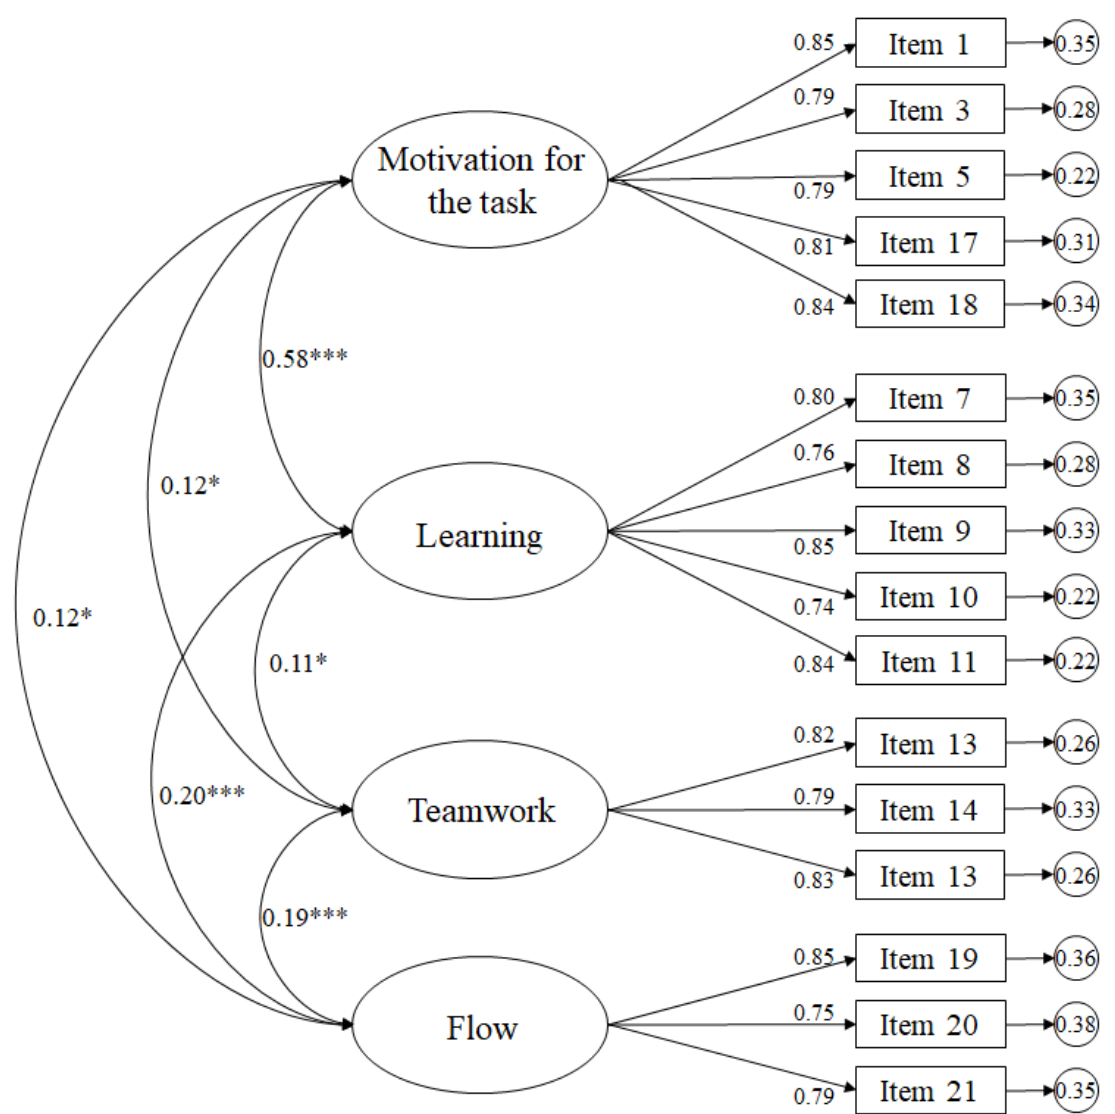
Figure 1. The ellipses represent the factors, and the rectangles represent the different items. The residual variances are shown in the small circles. *** p < 0.001; * p < 0.01